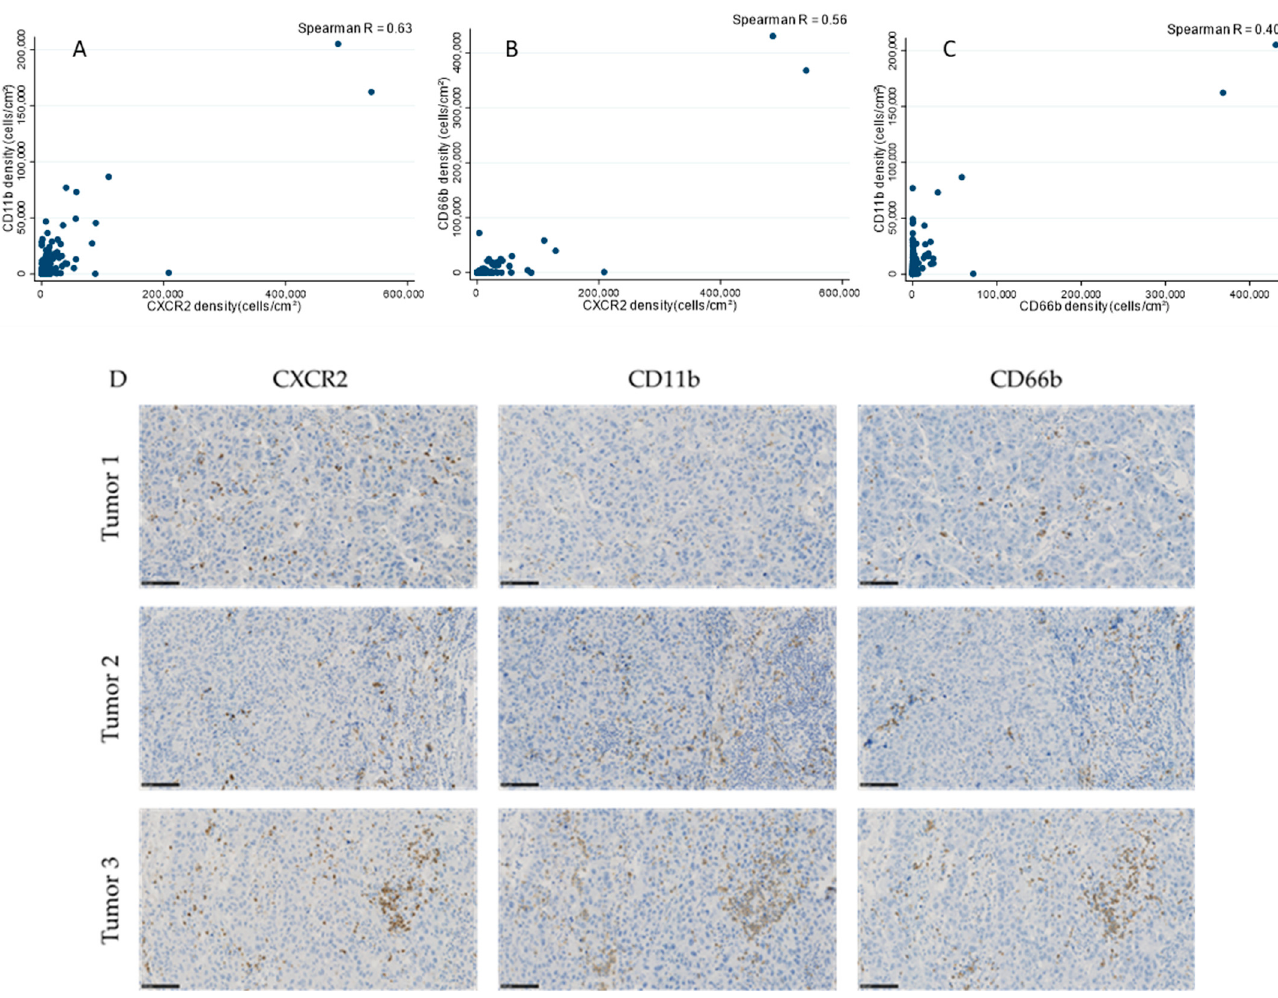
Figure 1. Correlations between CXCR2+ cell density and ( A ) CD11b+ cell density (Spearman’s rho = 0.63), ( B ) CD66b infiltration (Spearman’s rho = 0.56) and ( C ) between CD11b+ and CD66b+ cell density (Spearman’s rho = 0.40) in TNBC samples. ( D ) Representative images of TNBCs with variable CXCR2+ cell densities and corresponding CD11b and CD66b infiltration. Scale bar: 100 µm.